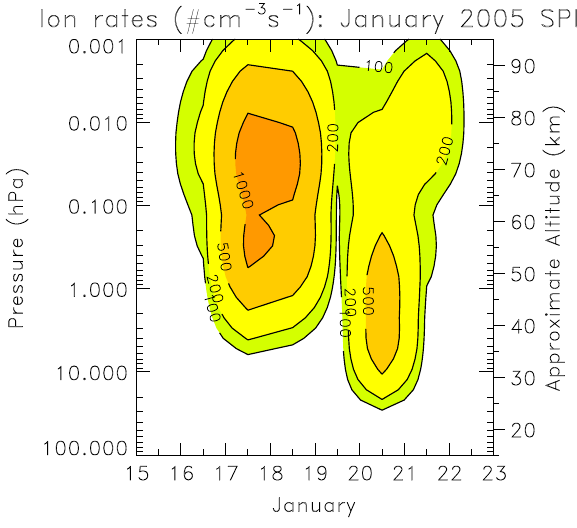
Fig. 1. Daily average ion pair production rates (#cm − 3 s − 1 ) for the “SPEs-only” case (protons with energy 1–300 MeV) as a function of time for 15–22 January